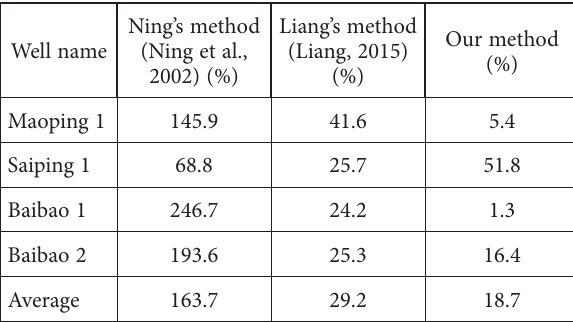
Table 6. Statistics of calculation